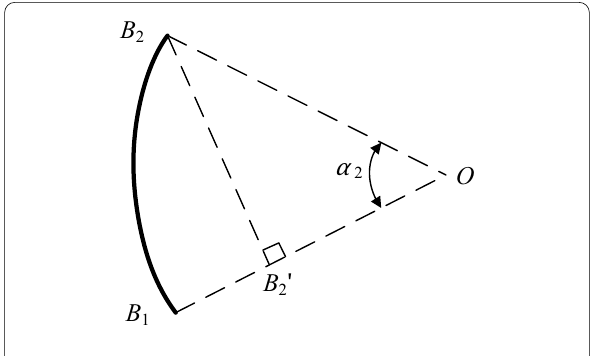
Figure 4 Front view of link B 1 B 2